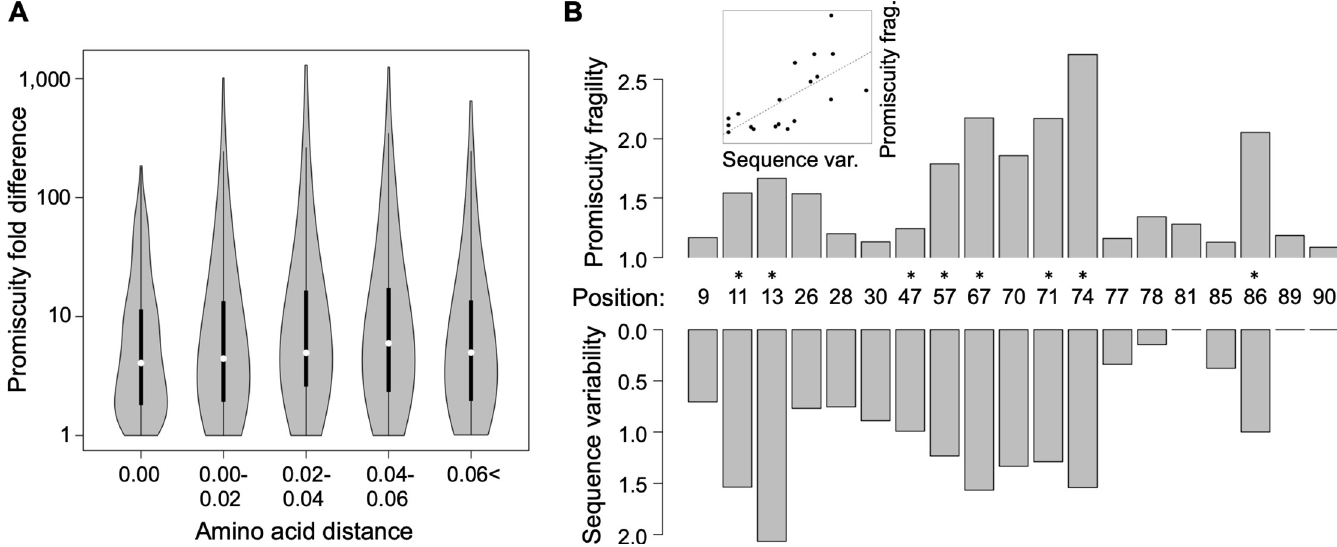
Fig 3. Promiscuity changes rapidly during evolution and might be a selectable trait. (A) For all pairs of selected alleles, the predicted promiscuity difference between two HLA-DRB1 alleles is shown as a function of amino acid distance measured after excluding the epitope-binding region. Large differences in promiscuity can be observed even between closely related pairs of alleles (e.g., at zero amino acid distance). As a result, there is no correlation between amino acid distance and promiscuity fold difference (Spearman’s rho = 0.02, P = 0.19). Amino acid distances were binned as shown on the figure ( n = 308, 1,168, 564, 654, 1,492). Violin plots show the density function of promiscuity fold difference values for allele pairs in the given bin. White circles show median values; bold black lines show the interquartile range. (B) Sequence variability of an amino acid site in the epitope-binding region of HLA-DRB1 (measured as Shannon entropy) correlates positively with the site’s promiscuity fragility, measured as the median predicted promiscuity fold difference caused by a random amino acid change at the given site (see inset, Spearman’s rho: 0.76, P = 0.0001). Sites that have a larger impact on promiscuity are more diverse in human populations. Line in inset represents linear regression between the two variables. The same result was obtained when promiscuity fragility was calculated based on nucleotide substitutions instead of amino acid substitutions (Spearman’s rho: 0.73, P = 0.0004, see Methods) or when sequence variability was measured as nonsynonymous nucleotide diversity ( π A ) instead of sequence entropy (S7 Fig). Sites under positive selection as identified by Furlong and colleagues [48] show significantly higher promiscuity fragility (Wilcoxon rank sum test, P = 0.0012) and are marked with asterisks (see also S8 Fig). The underlying data for this figure can be found in S4 Data.